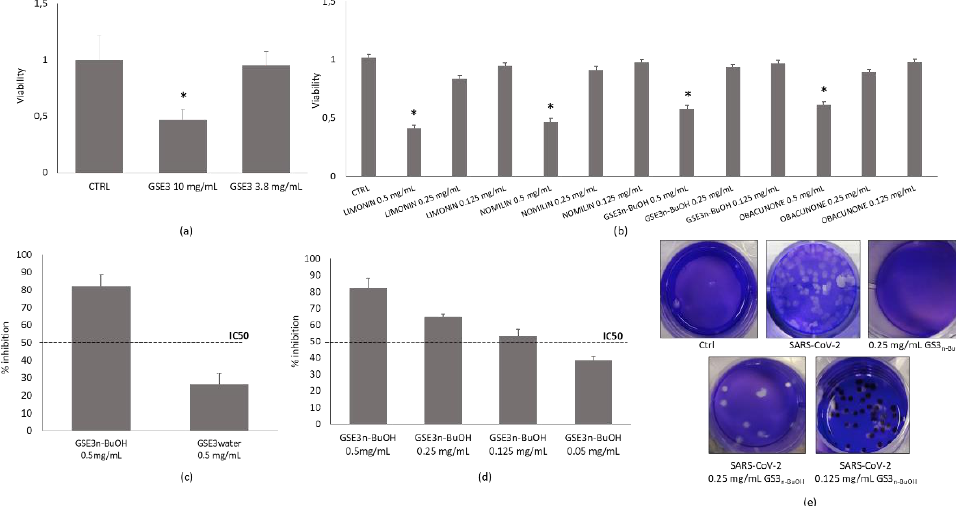
Figure 3. Virucidal effect against SARS-CoV-2. Cellular viability after exposure of Vero E6 cells to ( a ) GSE3 ; ( b ) GSE3 n-BuOH extract and single components; ( c ) rate of viral of inhibition by GSE3 n-BuOH and GSE3 water ; ( d ) rate of viral of inhibition by GSE3 n-BuOH dilutions; ( e ) SARS-CoV-2 plaques after fixing and staining with crystal violet after 72 h. * p < 0.05 compared to control (CTRL) group. Besides GSE3 n-BuOH and GSE3 water , the single limonoids obacunone ( 1 ), limonin ( 2 ), nomiline ( 3 ) of F1 fraction, and F2 fraction containing narirutin ( 4 ) + naringin ( 5 ) were also tested against the virus. Results demonstrated that the activity of GSE3 n-BuOH was mainly due to limonoids. In fact, obacunone ( 1 ), limonin ( 2 ) and nomilin ( 3 ) were all effective against SARS-CoV-2, with IC 50 ranging between 15 and 31 µg/mL, as shown in Figure 4. No inhibitory effect has been shown by the fraction F2 containing narirutin ( 4 ) + naringin ( 5 ).